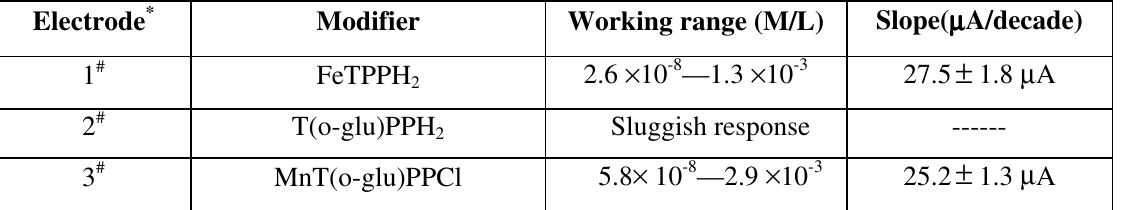
Table 1 Response characteristics of the modified